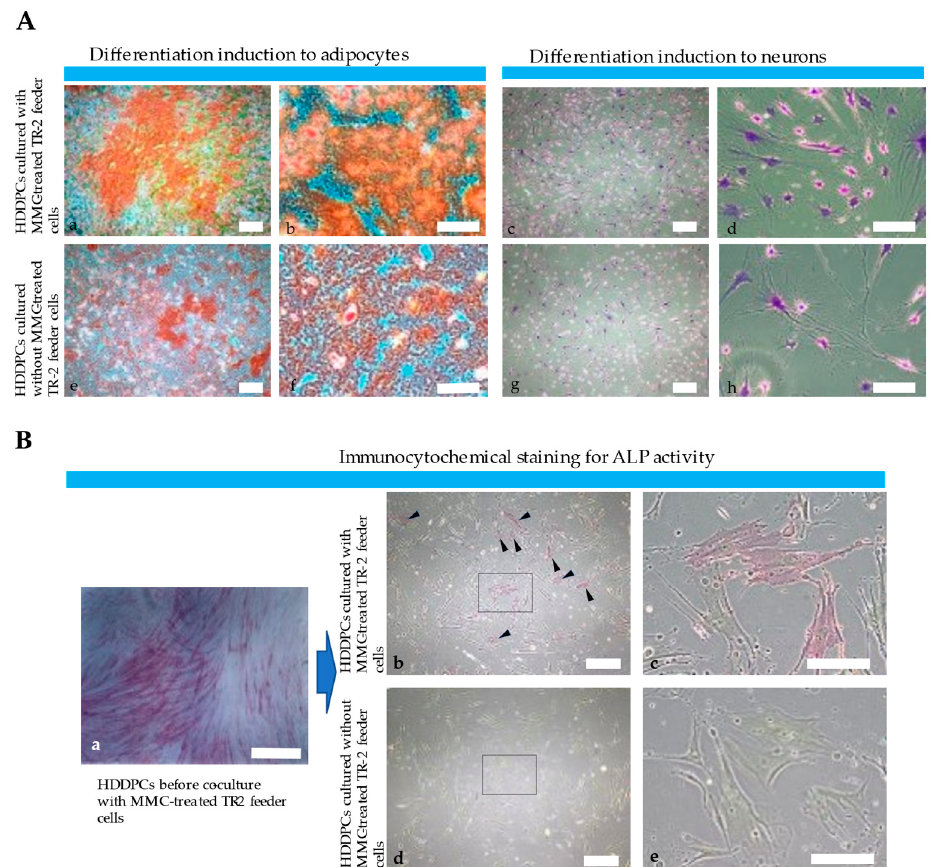
Figure 4. Characterization of freshly isolated primary HDDPCs cultured with or without TR-2 feeder cells (II). ( A ) Osteogenic and neurogenic differentiation of primary HDDPCs cultured in the (a–c), and (d) presence or (e–g), and (h) absence of TR-2 feeder cells. (a,b,e,f) Alizarin red staining 5 d after incubation in osteogenic medium. (c,d,g,h) Nissl staining 7 d after incubation in neurogenic medium. HDDPCs cultured with TR-2 feeder cells exhibited better differentiation than those cultured without TR-2 feeder cells. Scale bars = 100 µm [(a,c,e,g)] and 50 µm [(b,d,f,h)]. ( B ) Expression of ALP (a stem cell marker). Cytochemical ALP staining of HDDPCs (a) before culturing with TR-2 feeder cells, (b,c) cultured with TR-2 feeder cells for 20 passages, and (d,e) cultured without TR-2 feeder cells for 20 passages. The former maintained ALP activity [arrowheads (b)]. The boxes in (b,d) are enlarged and shown as (c,e), respectively. Scale bars = 100 µm [(a,b,d)] and 50 µm [(c,e)]. ALP: alkaline phosphatase; HDDPC: human deciduous dental pulp cells; MMC: mitomycin-C.